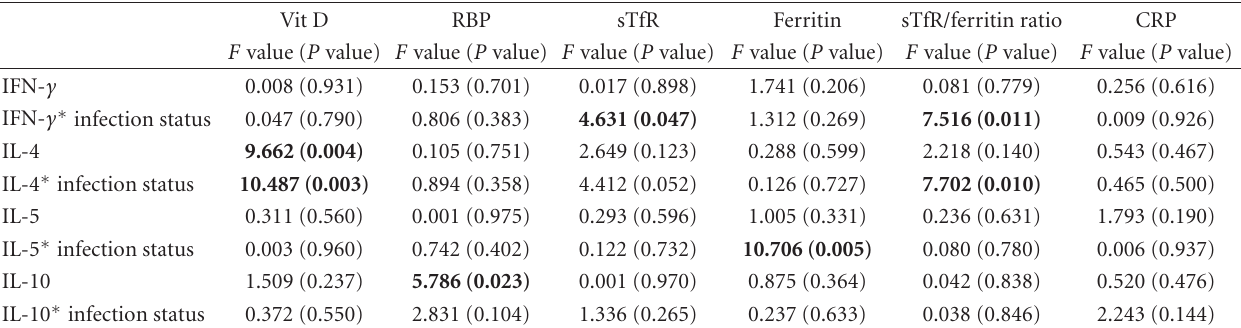
Table 2: F and P values obtained from ANOVA determining the association between cytokine levels and micronutrient levels. Vit